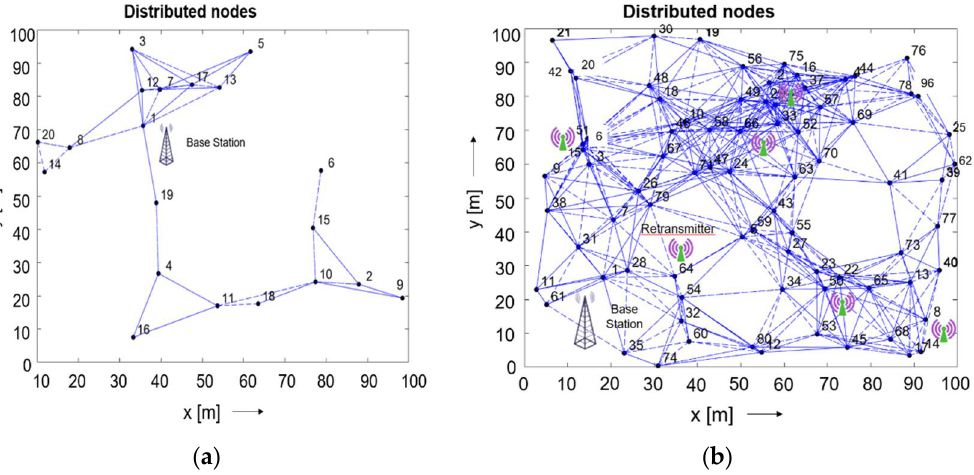
Figure 7. Distributed number of nodes, 20 and 80, in ( a , b ), respectively. Area length = 100 m, area width = 100 m, expected sensor reading = 100, and size of the data packet = five bytes.